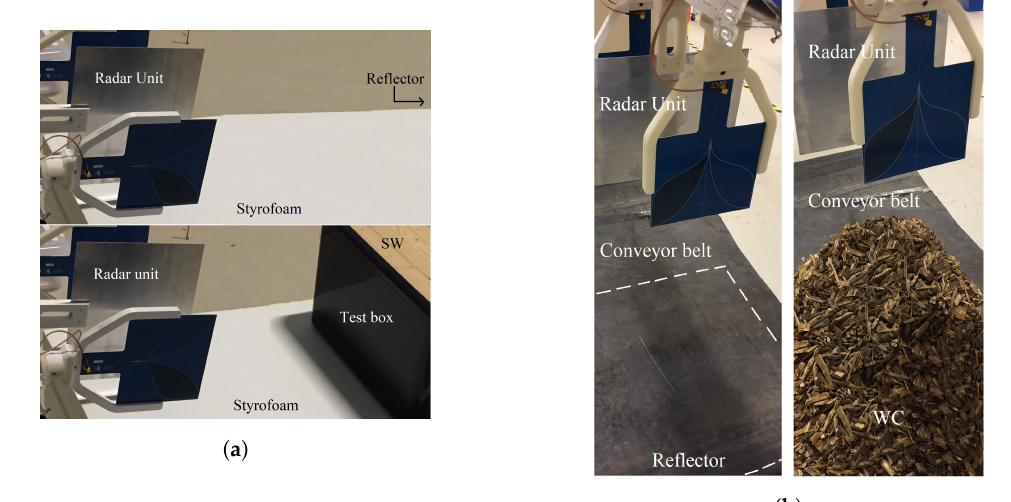
Figure 6. Photographs of ( a ) Setup I: reference measurement (top) and measurement of Object A (bottom). ( b ) Setup II: reference measurement (left) and measurement of Object D (right).